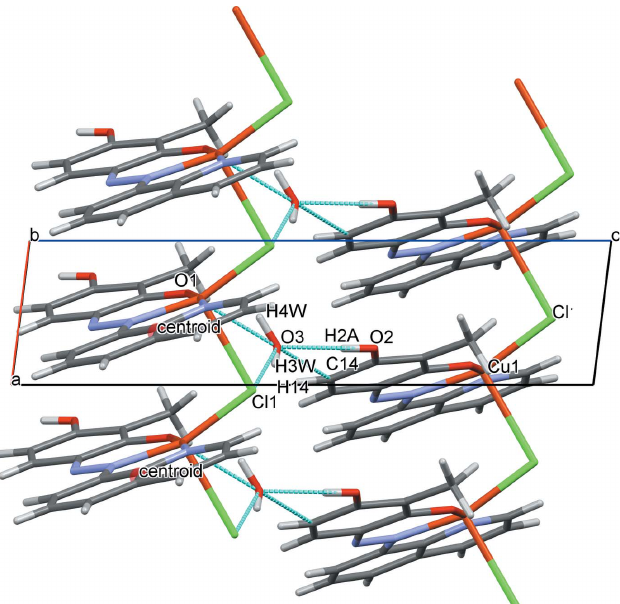
Figure 2 Crystal packing of the title compound viewed along the b axis showing intermolecular hydrogen bonds and (cid:2) – (cid:2) stacking between the azo ligands, generated with Mercury software (Version 2021.2.0; Macrae et al. , 2020). Intermolecular hydrogen bonds are shown as blue dashed lines.